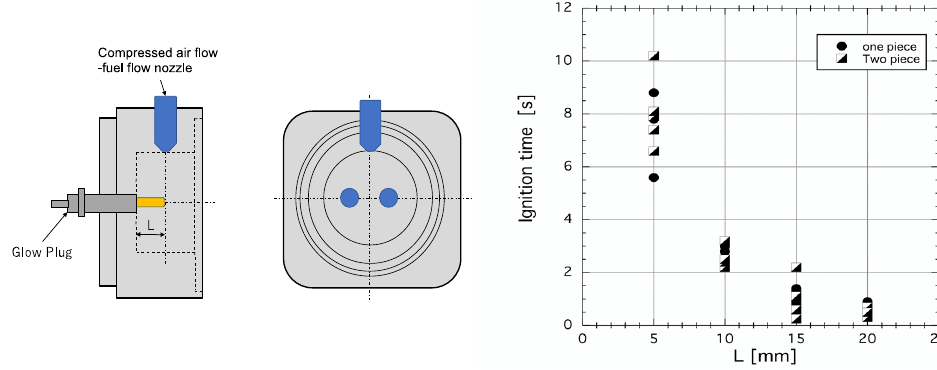
Figure 7. Relationship between glow plug position and time to